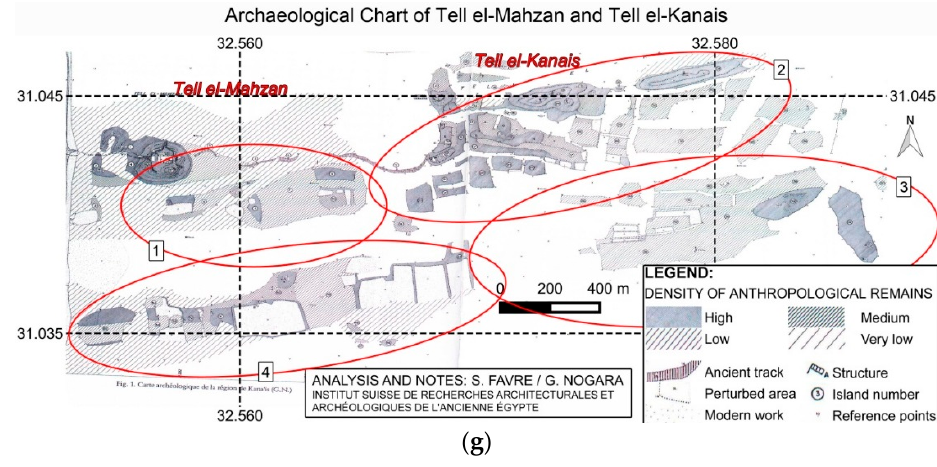
Figure 8. ( a ) Map showing subset region of Tell el-Farama, Tell el-Mahzan, and Tell el-Kanais (AOI 2) marked by red star; ( b ) average De Grandi filtered PALSAR-1 σ ° backscatter over subset region of Tells shown in ( a ). Yellow ellipses highlight anomaly features. PALSAR-1 data provided by ESA. ( c ) Coefficient of variation of seven PALSAR-2 Spotlight multitemporal De Grandi speckle filtered images over same subset region of Tells. Yellow ellipses highlight anomaly features. PALSAR-2 data provided by JAXA. ( d ) Sentinel-2 image over same subset region of Tells, acquired on 19 February 2016. Full resolution (10 m) true colour composite of band 4 (650 nm) displayed as red, band 3 (543 nm) displayed as green, and band 2 (458 nm) displayed as blue. The red rectangle shows the coverage of an archaeological chart published by Jaritz, Favre, Nogara, Rodziewicz and Carrez-Maratray [58]. Yellow ellipses show locations of anomalous features identified in the PALSAR-1 and PALSAR-2 processed imagery. Contains modified Copernicus Sentinel data 2016. ( e ) Pleiades image acquired on 24 November 2015, covering area included in the red rectangle in ( d ). Pansharpened to 0.5 m pixel spacing. True colour composite of band 3 (660 nm) displayed as red, band 2 (550 nm) displayed as green, and band 1 (490 nm) displayed as blue. Yellow ellipses show locations of anomalous features identified in the PALSAR-1 and PALSAR-2 processed imagery. Pleiades data provided by ESA. ( f ) Coefficient of variation of 7 PALSAR-2 Spotlight multitemporal De Grandi speckle filtered images over same subset region as ( e ). Yellow ellipses show locations of anomaly features. PALSAR-2 data provided by JAXA. ( g ) Archaeological chart published by Jaritz, Favre, Nogara, Rodziewicz and Carrez-Maratray [58] covering same area as in ( e , f ). Red ellipses show locations of anomalous features identified in the PALSAR-1 and PALSAR-2 processed imagery. Courtesy of Jaritz, Favre, Nogara, Rodziewicz and Carrez-Maratray [58]. Table 3. Sensor names, acquisition dates, and characteristics of remotely sensed optical imagery used in the analysis of features over Tell el-Farama, Tell el-Mahzan, and Tell el-Kanais. Sensor